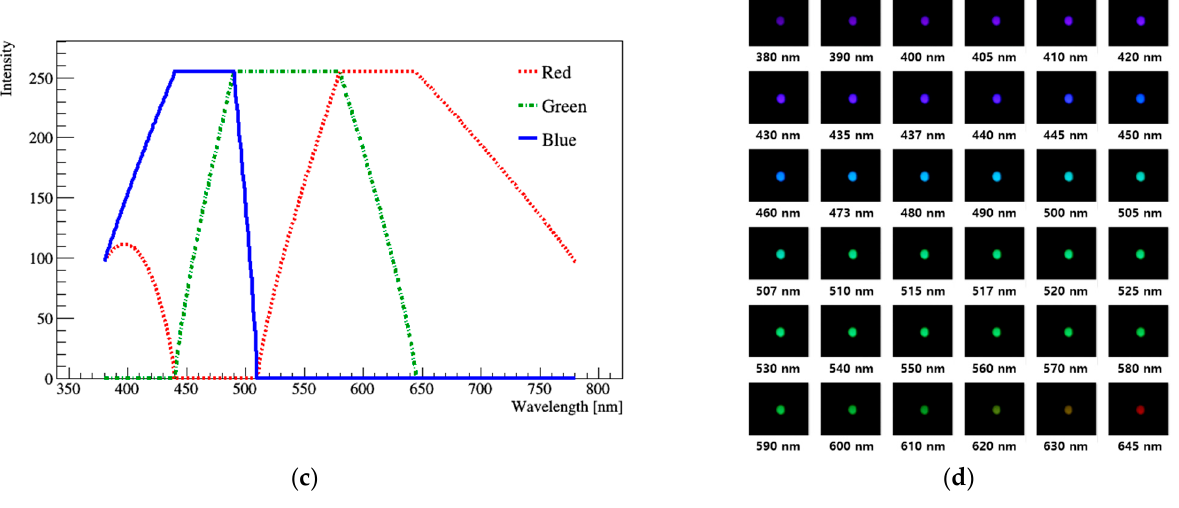
Figure 1. ( a ) Experimental setting for generating lights using LED disc. LED disc was connected to a single-board Arduino. ( b ) Schematic for taking digital image photo. Black foam was used as an L-shaped wall. The light from the hole passed through the grating or was directly imaged on the screen depending on the purpose of the experiment. ( c ) RGB intensity as a function of wavelength. ( d ) RGB color and corresponding wavelength. Light from blue to red was generated. Photographs were taken in increments of 10 nm with wavelengths ranging 380 to 645 nm.